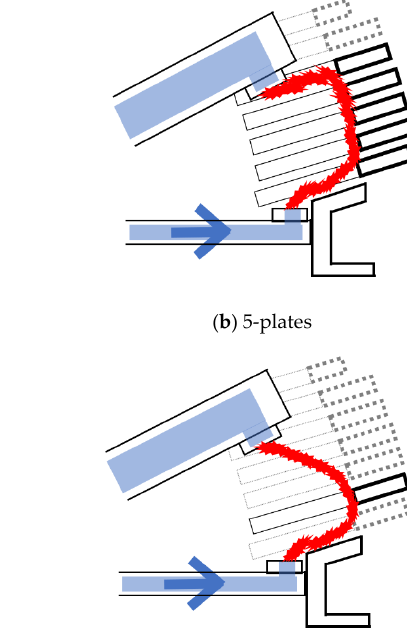
Figure 6. Voltage waveform between contacts without a splitter plate. Based on the voltage between the electrodes, the resistance ( R arc ) value of section II is obtained. (Figure 7). Section II of this modelling is measured from 1.2 ms to 7.3 ms. The resistance values are fitted as a primary function, and the error rate is 2.13%. This linearized resistance value is used as the resistance ( R arc ) in section II in the circuit model. Figure 7. Resistance ( R arc ) between the contacts in section II. The arc generated by the separation of the contacts grows and expands towards the splitter plate. The forces at this point are hot gas emissions and Lorentz power, as mentioned earlier. The Holm force is a very small value, so it is omitted here. Hot gas produced by arc discharge causes temperature differences, i.e., pressure differences, within the circuit breaker space. The magnitude of